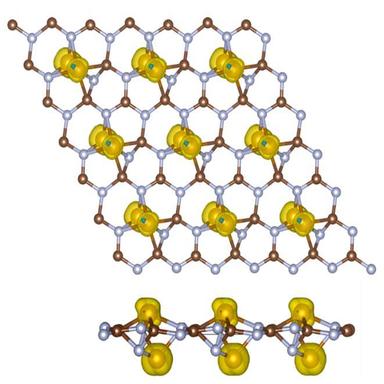
Spin density distribution of (Fe2)@g-CN1 (top and side views). Nitrogen atoms are depicted in grey, carbon atoms are depicted in brown, iron atoms are in golden. Uncompensated spin-up densities are depicted in yellow.